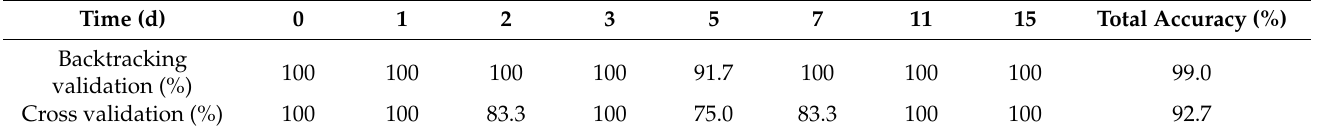
Table 4. Classification results of CSA data of samples at different fermentation time by LDA.